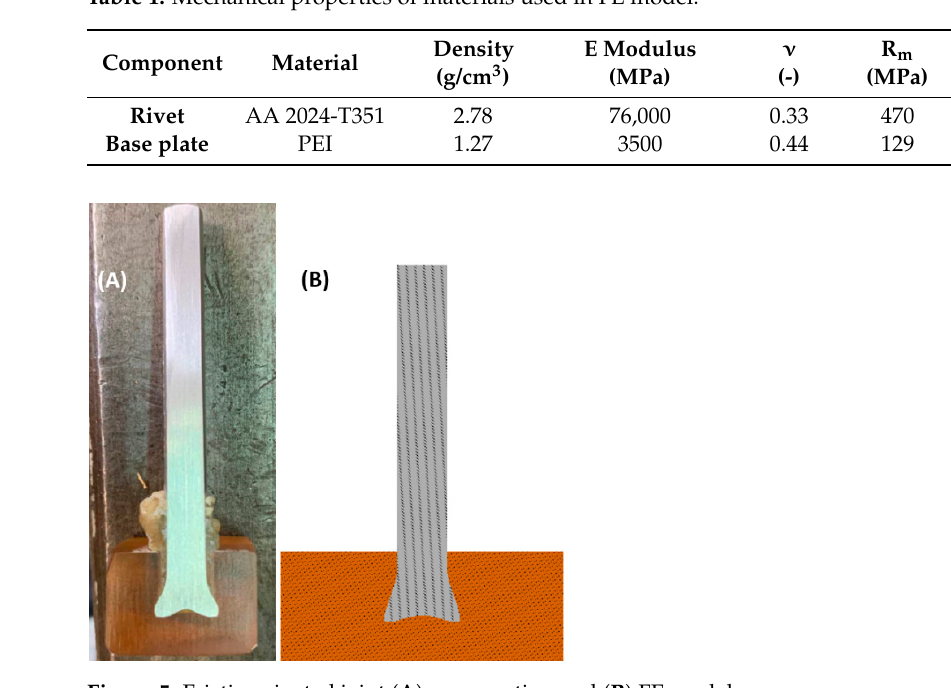
Table 1. Mechanical properties of materials used in FE model.